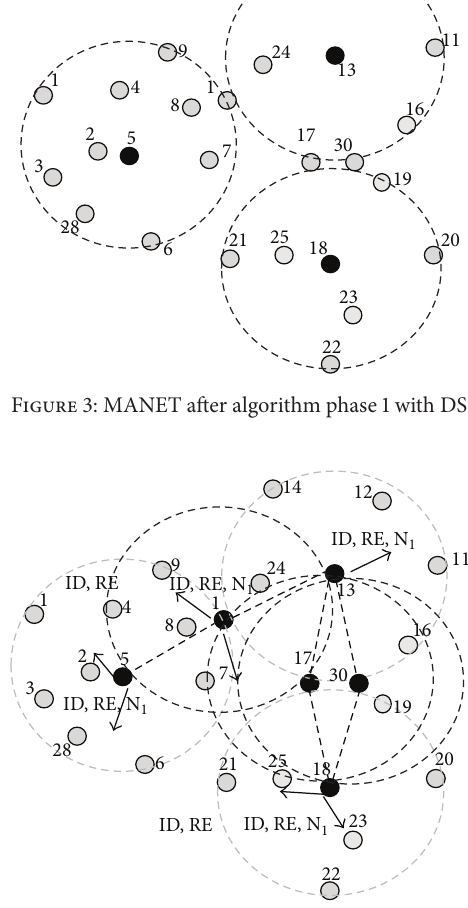
Figure 4: Connectors are selected after algorithm phase 2 and (ID, RE, and 𝑁 1 ) are exchanged to get equivalent node for performing activity